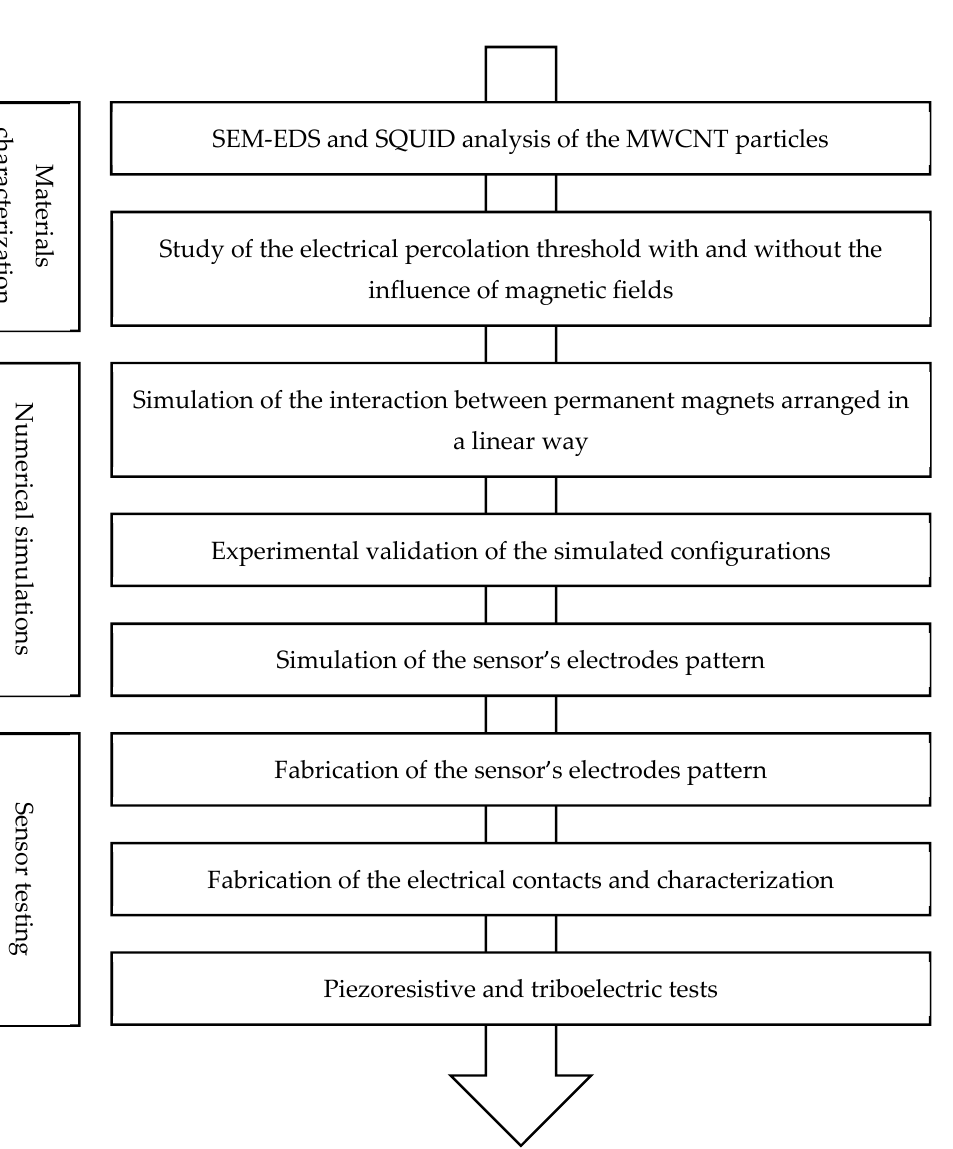
Figure 1. Overview of the workflow carried out.